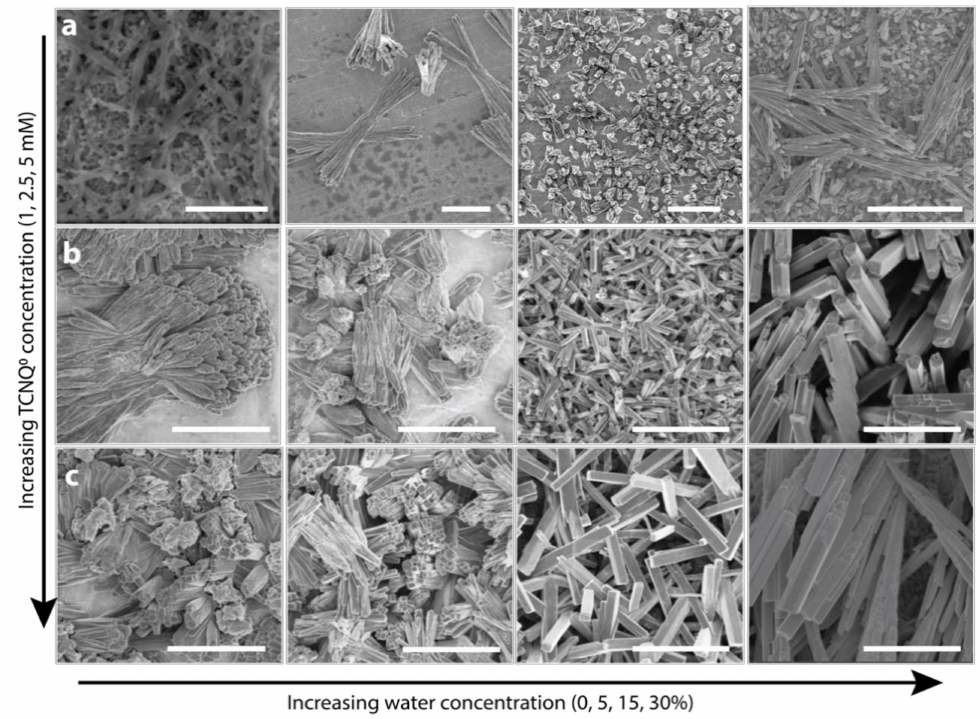
Figure 2. Material characterization of CuTCNQ. SEM images of CuTCNQ grown on Cu foil using ( a ) 1 mM, ( b ) 2.5 mM, and ( c ) 5 mM TCMNQ in DMSO with increasing concentration of water (0, 5, 15, 30% v / v ). The scale bar is 5 µ m except for ( a ) 1 mM 0% H 2 O which is 500